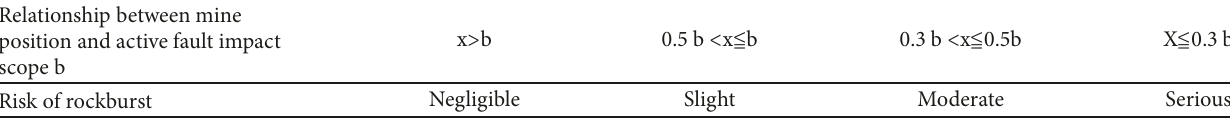
Table 6: Risk of rockbursts in different areas of active fractures.